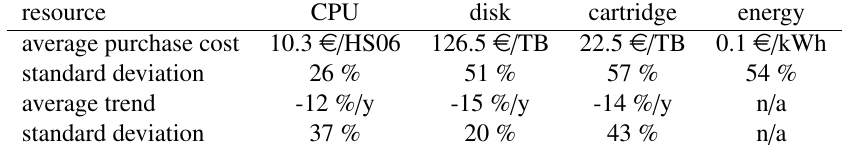
Table 2. Site costs summary (as of 2018) and yearly evolution observed over the previous